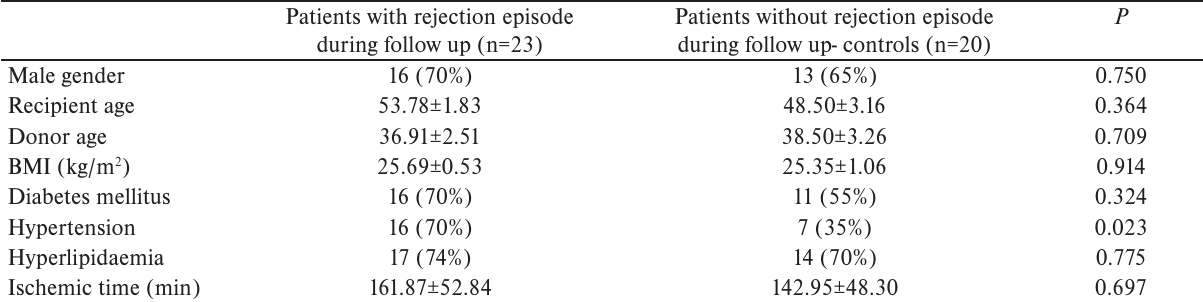
Table 1. Baseline characteristics of both groups, patients who experienced rejection episode and patients who were free from rejection – controls.